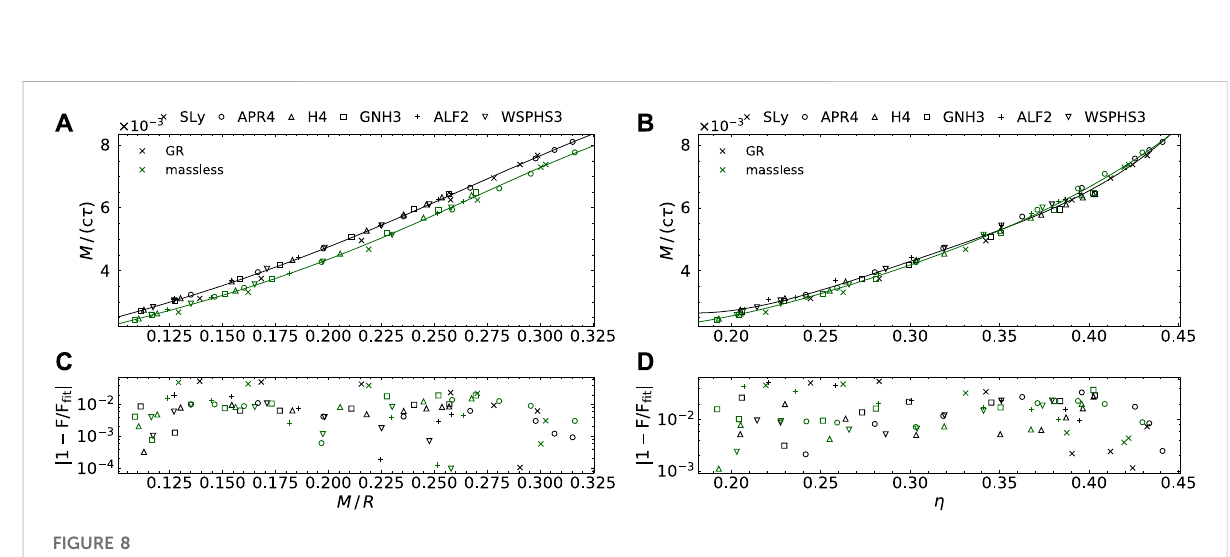
FIGURE 8 Dipole ϕ -mode universal relations: dimensionless inverse damping time M /( c τ ) (A,B) and fi t errors (C,D) versus compactness C = M / R (A,C) and versus generalizedcompactness η (B,D) .Thesymbolsindicatetherespectiveequation ofstate,andthecolorgreenindicatesthemasslesscase, with the general relativistic case in